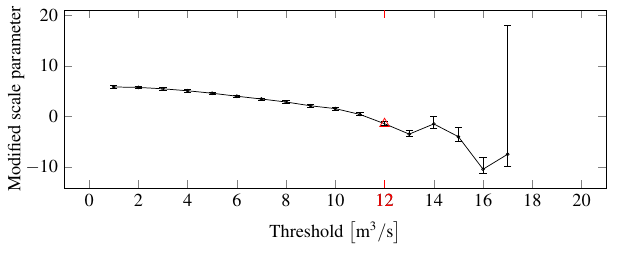
Figure 4. Mean excess versus threshold, with the chosen threshold shown in red.